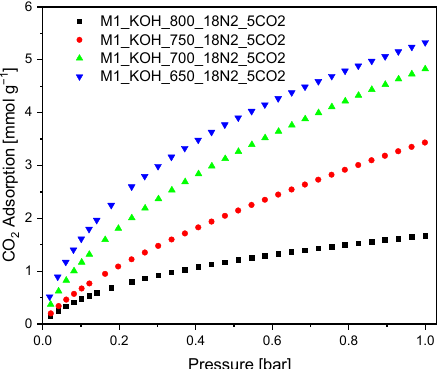
Figure 3. CO 2 adsorption isotherms measured at 0 °C.